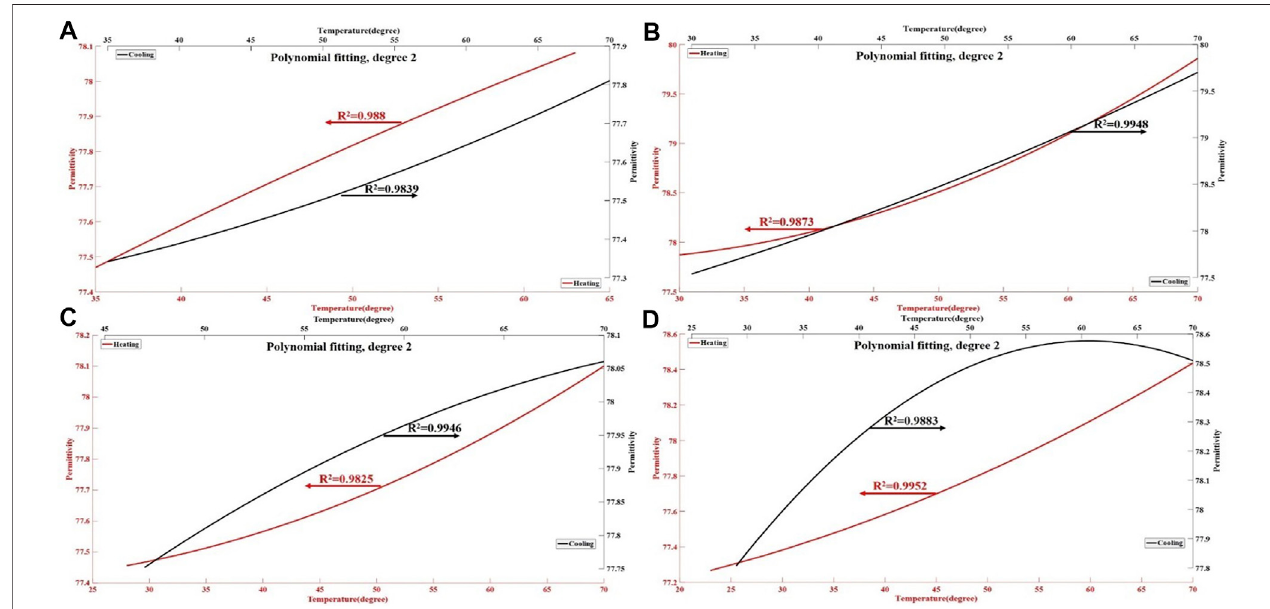
FIGURE5| Thepermittivity changesof exvivo livertissueduringthe heatingand cooling process. The redlinesin the fi gures (A – D) represent the polynomial curve fi ttingofthepermittivityoflivertissueduringtheheatingprocess, withan R 2 valuesof0.9825 – 0.9952.Theblacklinerepresentsthepolynomialcurve fi ttingofpermittivity of liver tissue during the cooling process, with an R 2 of 0.9839 – 0.9948. The results show an almost nonlinear relationship between the permittivity of liver tissue and temperature.